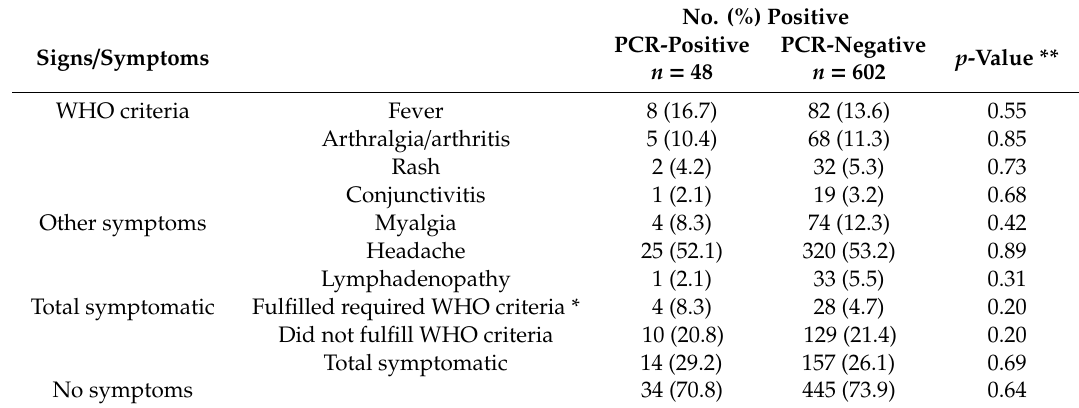
Table 3. Symptoms in women with and without PCR-confirmed ZIKV